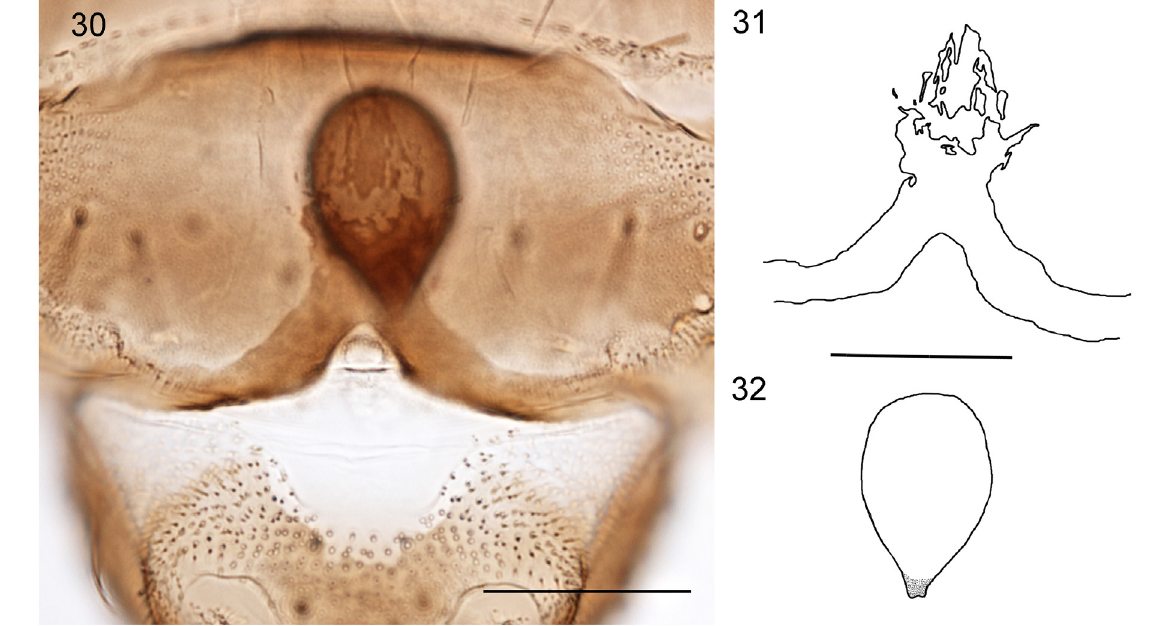
Figs 30–32. Dasyhelea gothlandica sp. nov., paratype, ♀. 30–31 . Subgenital plate. 32 . Seminal capsule. Scale bars = 50